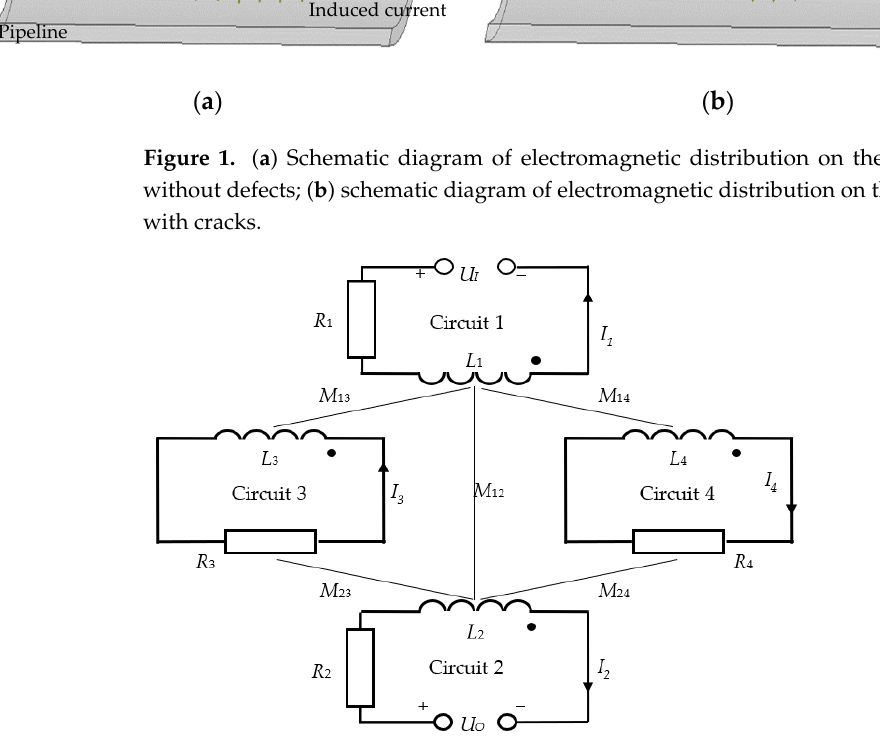
Figure 2. Mutual inductance model for detection of the balanced-field electromagnetic technique.